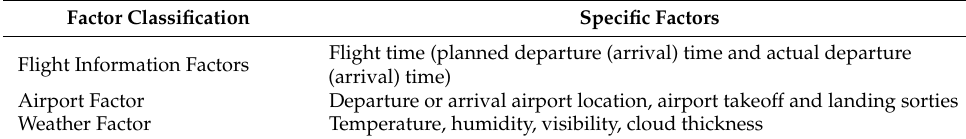
Table 1. Classification of influencing